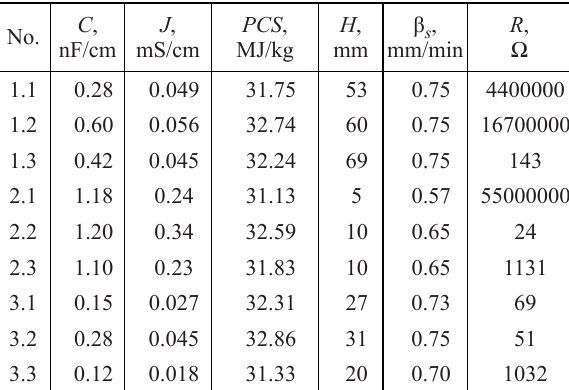
Table 4. Definite values of characteristics necessary for forecasting No.